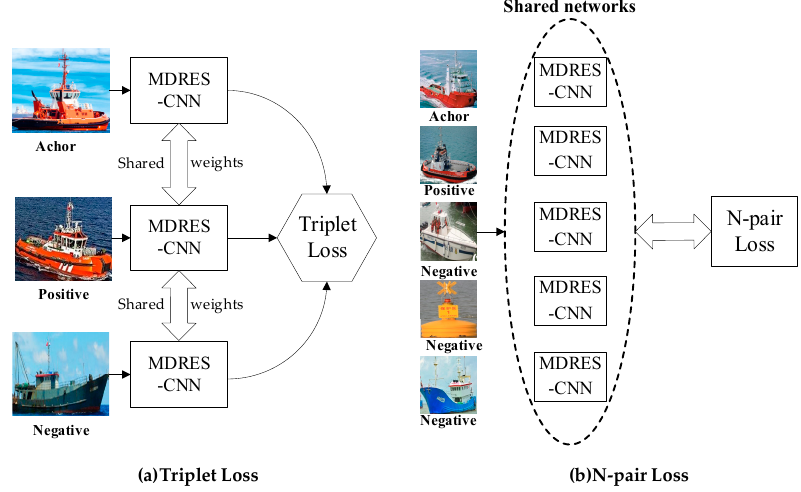
ff erent loss functions: ( a ) triplet loss; ( b ) N-pair Figure 7. The diagram of different loss functions: ( a ) triplet loss; ( b ) N-pair loss. Figure 7. The diagram of di